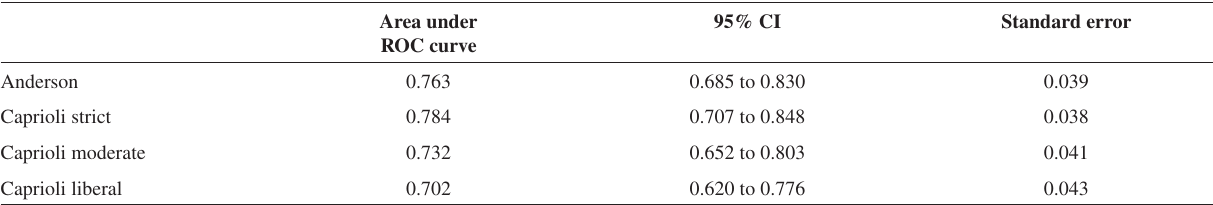
Table 3 - Area under the ROC curve for different analytic algorithms for SITA interpretation